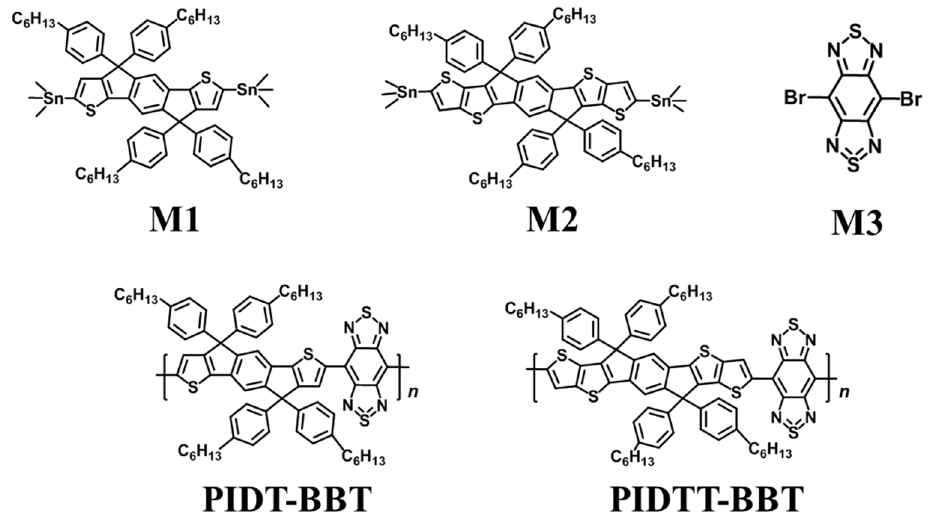
Figure 1. Chemical structure of the monomer and